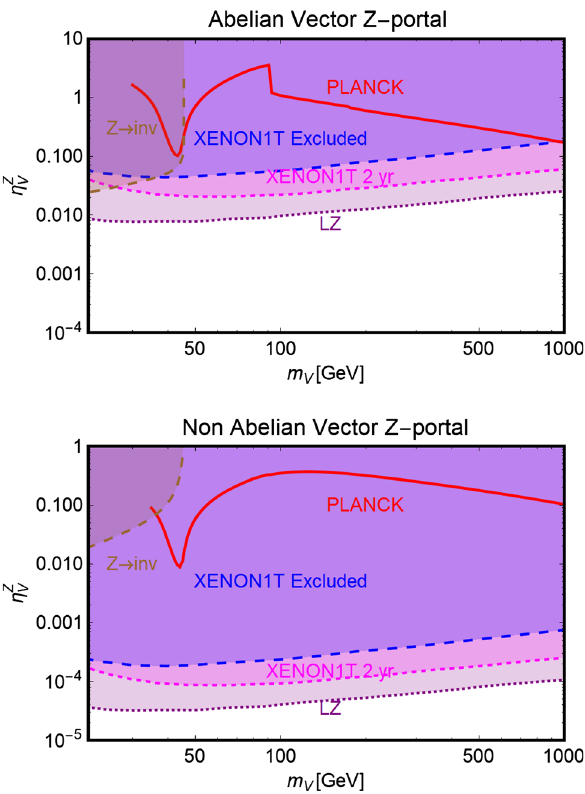
Fig. 8 The same as Fig. 6 but for vectorial DM with (i) Abelian case (top panel) and (ii) non-Abelian case (bottom panel) in the pertinent bi-dimensional plane m V - η Z